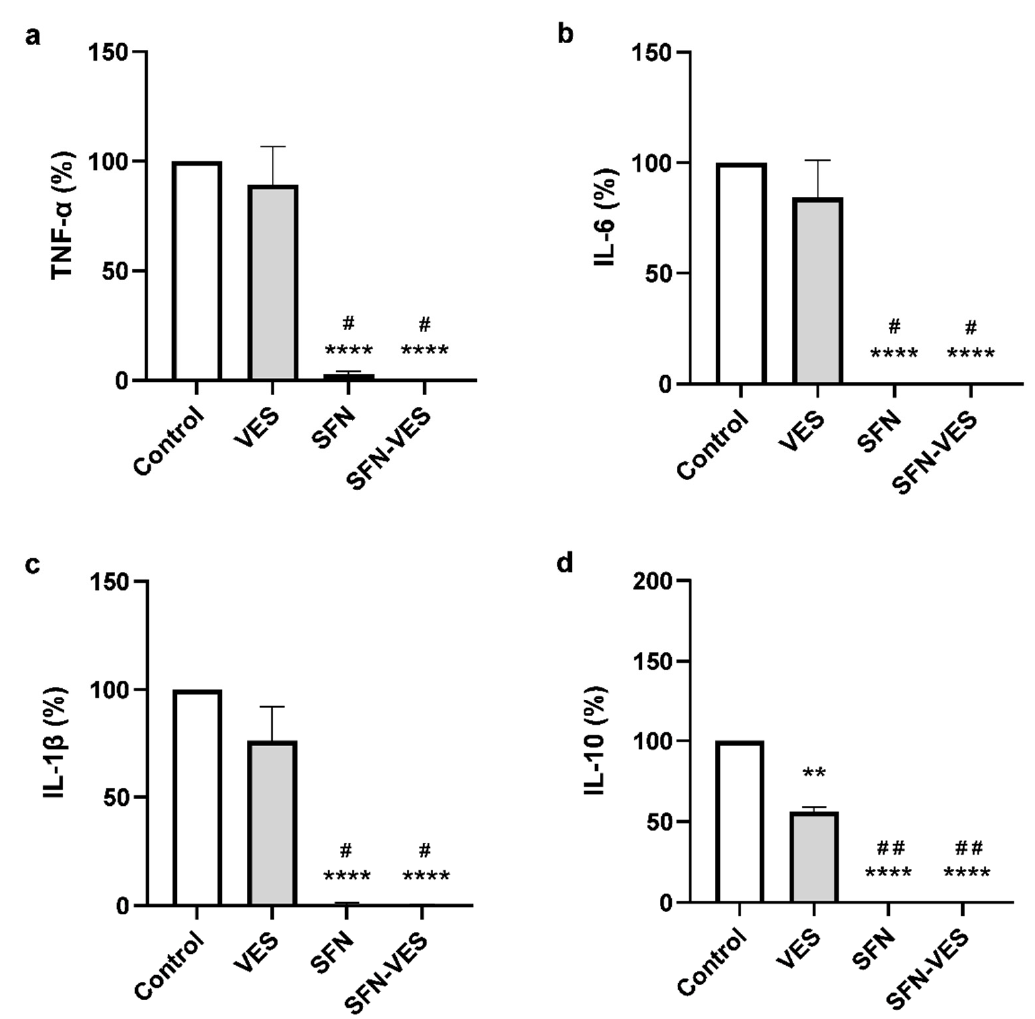
Figure 3. Modulation of cytokine production by treatment with Brassica derived compounds in human M1 macrophages. LPS stimulated primary cultures of human M1 macrophages were untreated (control) or treated for 24 h with, unloaded broccoli membrane vesicles 0.02 mg/mL (VES), free sulforaphane 25 µ M (SFN), or SFN-loaded broccoli membrane vesicles at 25 µ M (SFN-VES). TNF- α ( a ), IL-6 ( b ), IL-1 β ( c ) and IL-10 ( d ) cytokine production was assessed from M1 macrophages obtained from 5 healthy donors. Data were normalized relative to the untreated control for each experimental condition (valued as 100%) and represented as mean ± SEM. Significant differences with respect to the untreated control (*) or VES treatment (#) were calculated according to the one-way ANOVA analysis with a Tukey’s test as a post hoc test (** p < 0.01, **** p < 0.0001; # p < 0.05, ## p <